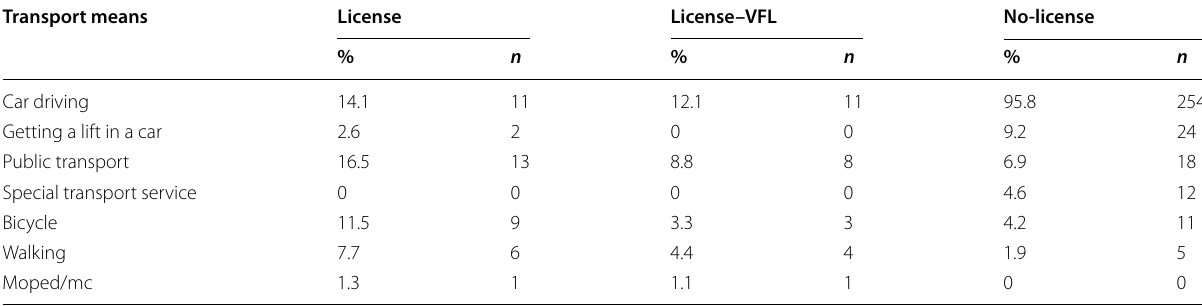
The respondents could choose several transport means or even refrain from choosing at all, so the percentages will not sum to 100